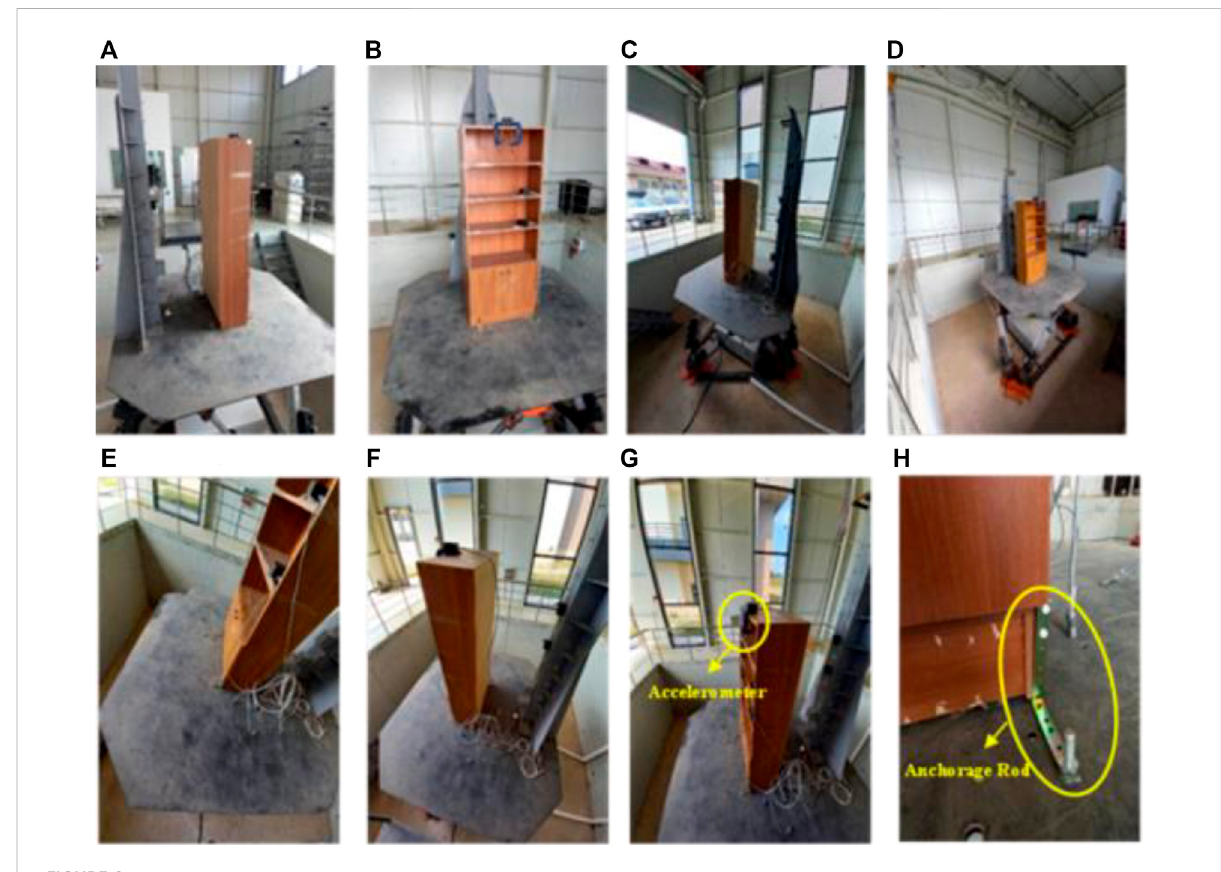
View of a bookcase NE on the shake table (Cavuslu,